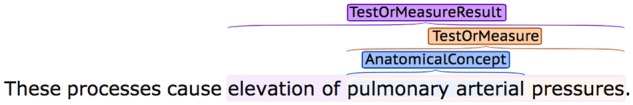
Example of a phenotype that includes other concepts nested within it.